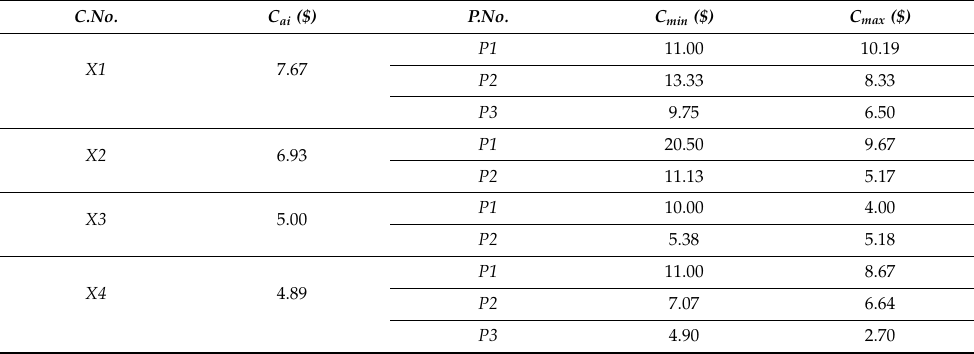
Table 2. Manufacturing cost of overrunning clutch assembly for t ai , t min , and t max